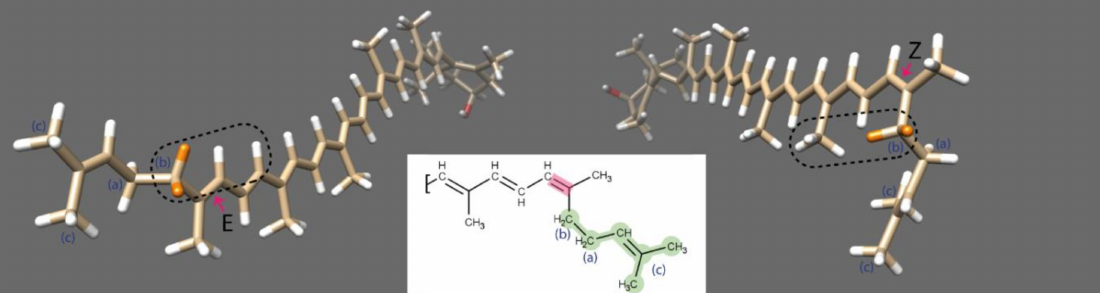
Figure 4. 3D structures of (all-E) -rubixanthin (left) and (5’Z) -rubixanthin (right), the 5’ double bond is highlighted in pink. The protons of CH 2 group adjacent to the 5’ double bond are marked in orange. As indicated by the dotted fields, in the (all-E) -rubixanthin this CH 2 group is exposed to CH protons only, whereas in the case of the (5’Z) -isomer it is additionally exposed to a methyl